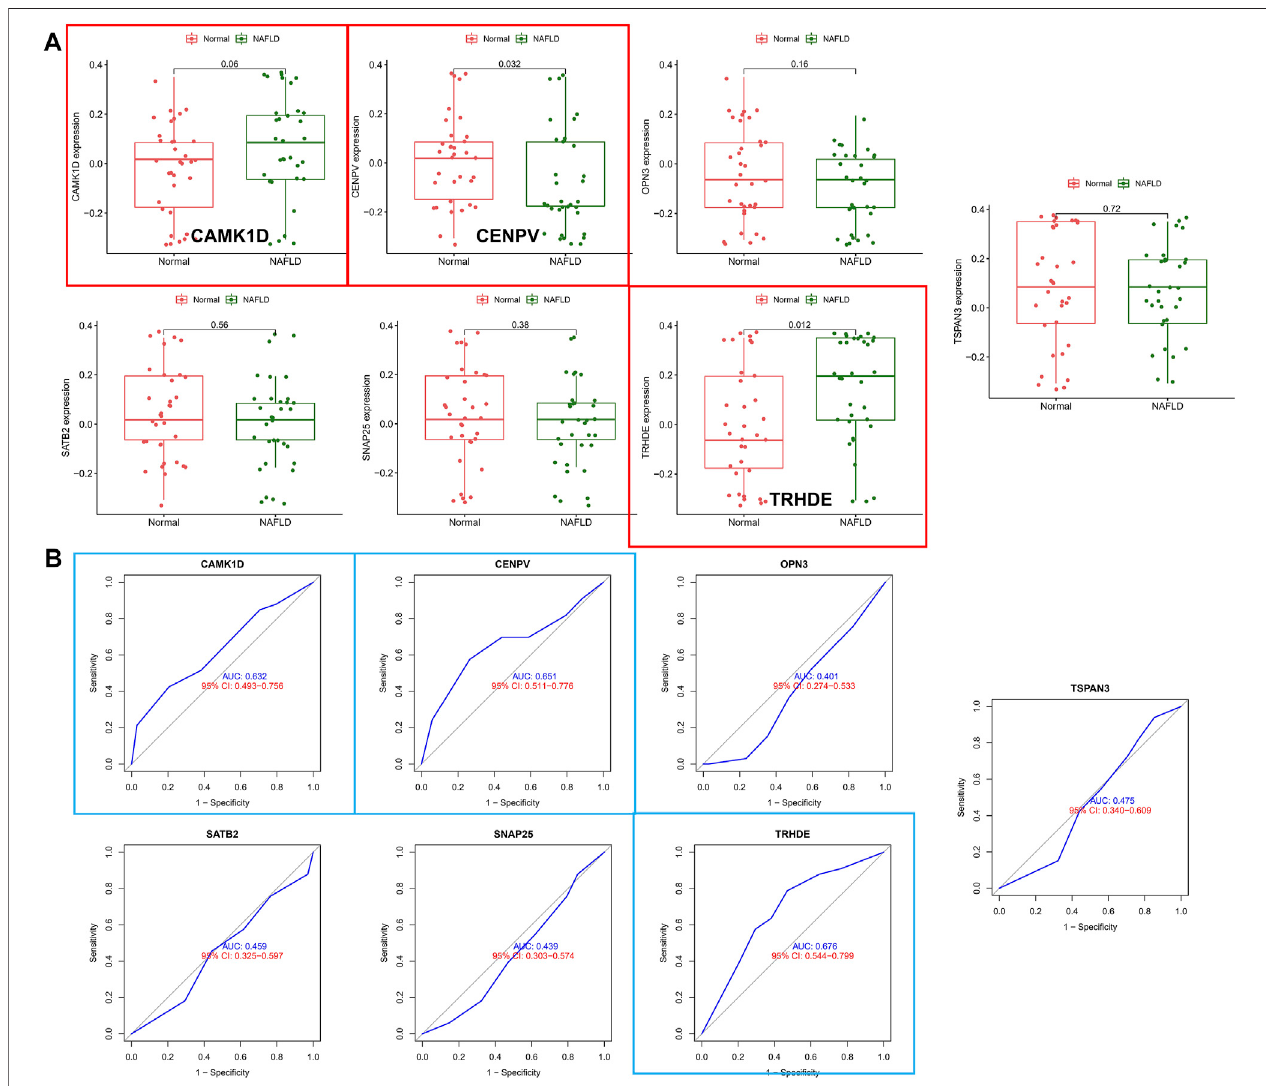
FIGURE5| Validationofhubbiomarkers. (A) Candidategeneswerevalidatedintheexternalvalidationset,andthosemarkedinred indicatedifferentialexpression between samples. (B) ROC analysis of candidate genes in the external dataset, with blue annotations indicating good predictive performance for the gene.